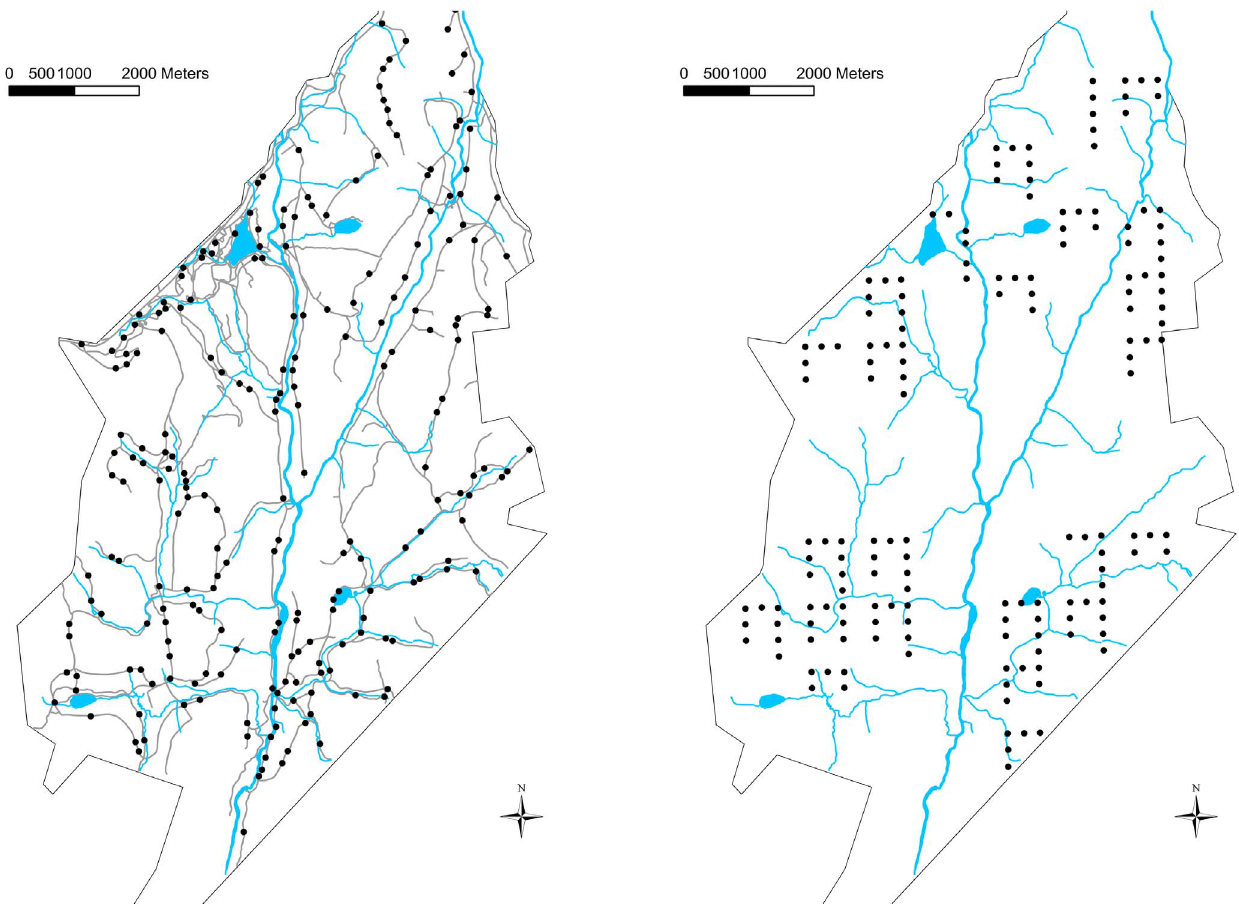
Figure 1. Sampling site locations at Foreˆt Montmorency (Que´bec, Canada). Sampling site locations on roads and trails (left) and systematic transects (right) at Foreˆt Montmorency (Que´bec, Canada) between 2009 and 2011. Blue lines and areas are rivers and lakes, while gray lines are unpaved forestry roads and trails.